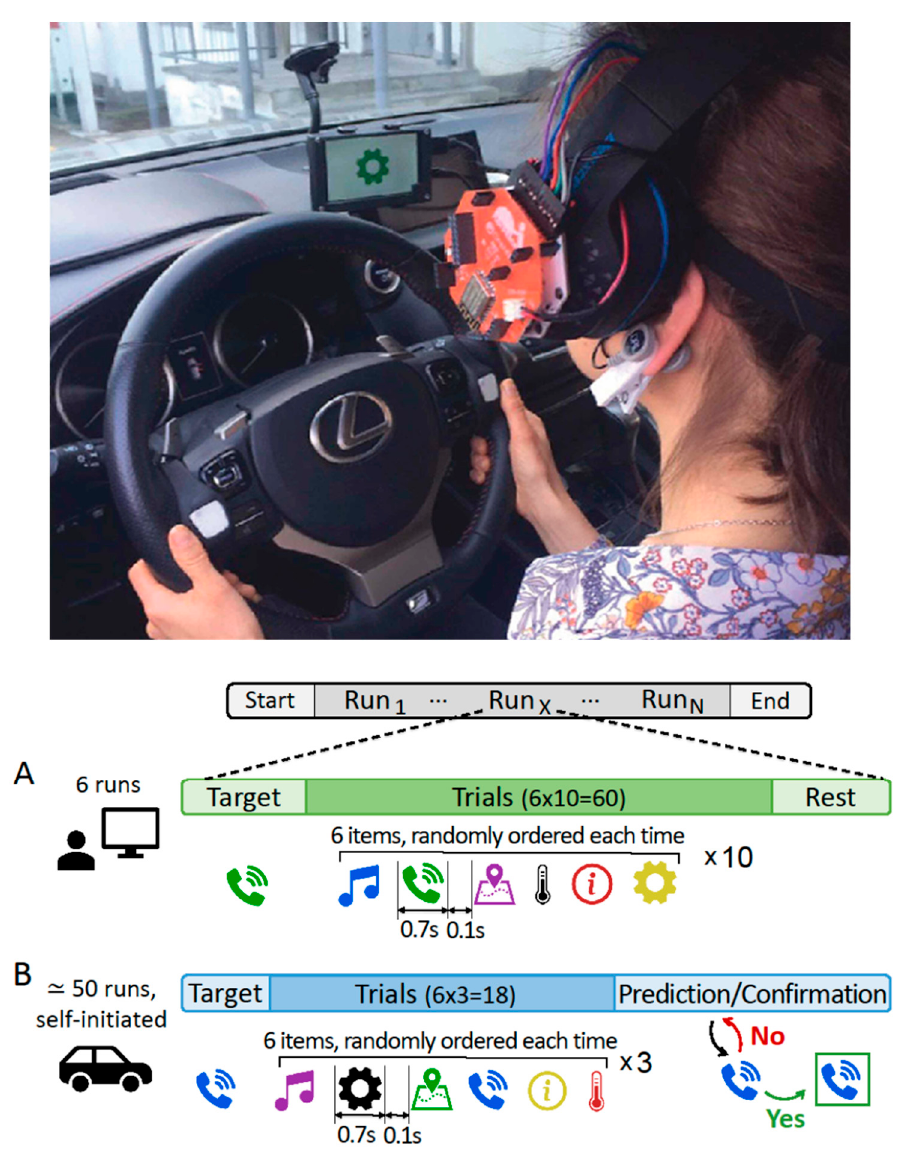
Figure 4. Visual representation of the BCI tasks. Upper picture shows a participant from the back wearing the EEG headset of the Biohub and performing the in-car session of the experiment. Panels ( A , B ) show the schema of the protocols used in the in-lab and in-car sessions.